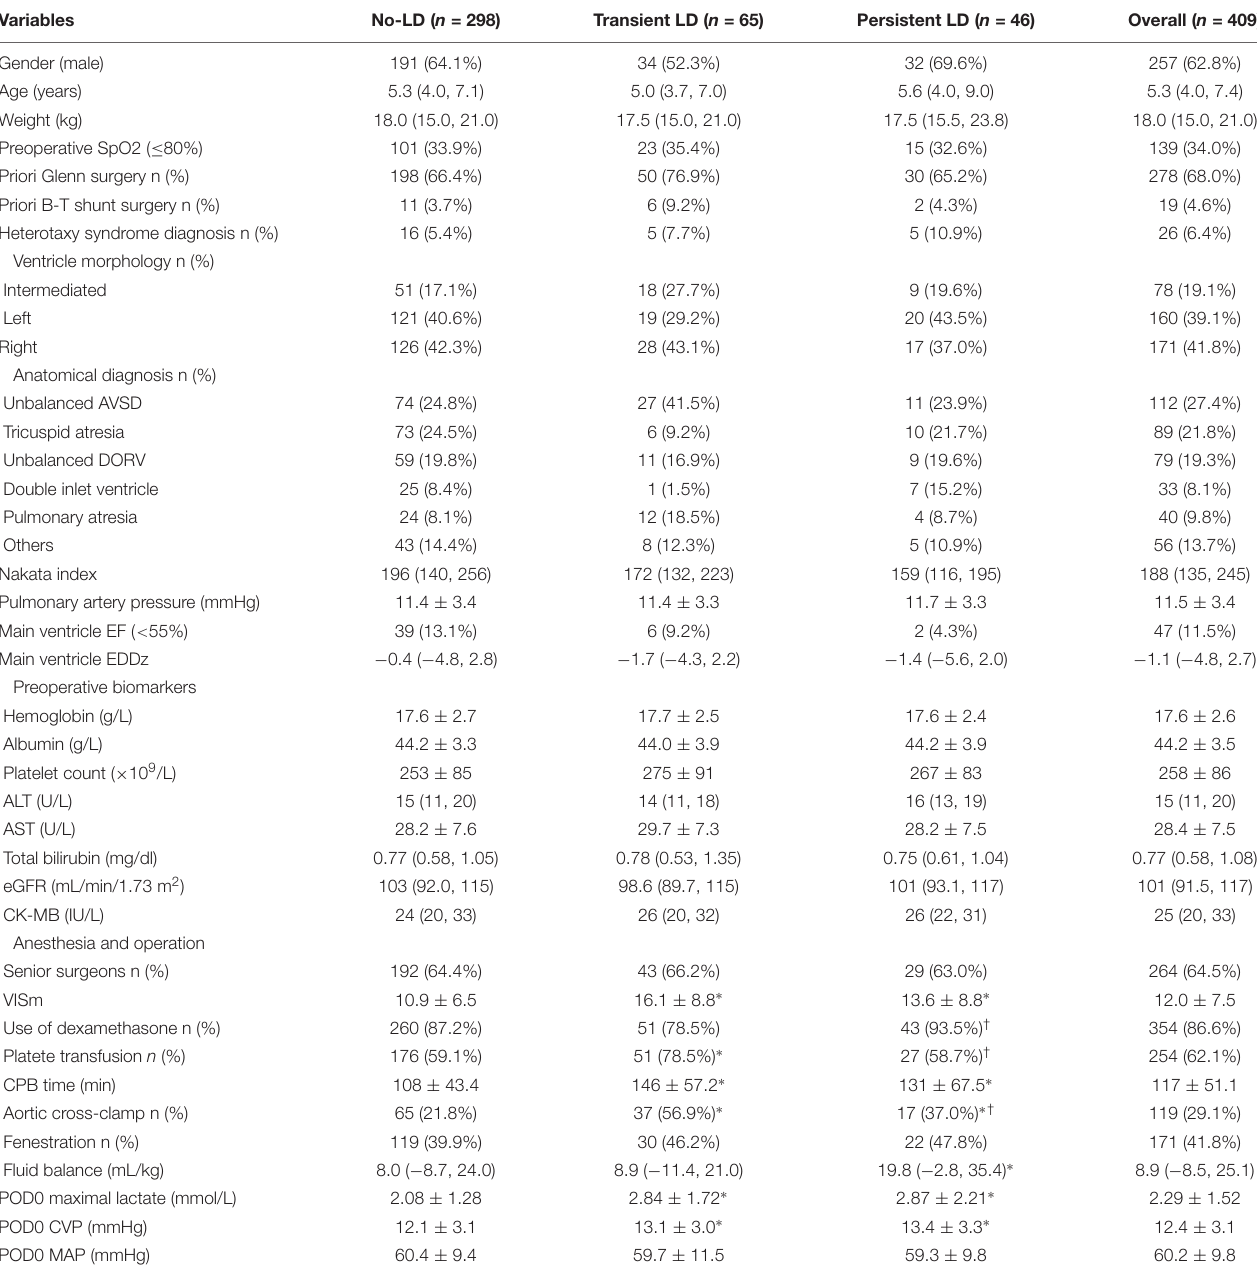
TABLE 1 | Patient characteristics and perioperative information according to the liver function